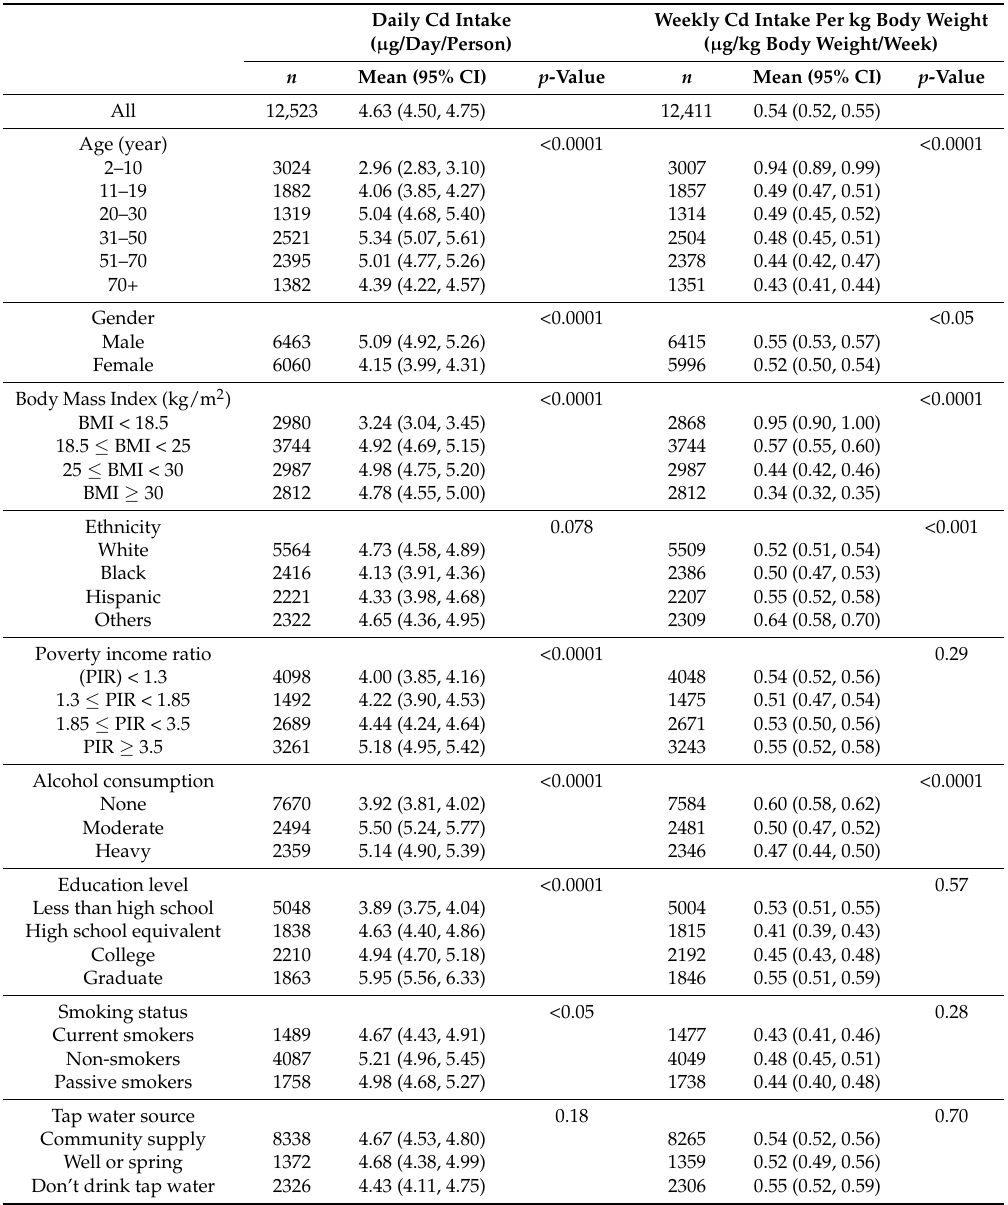
Table 1. Daily Cd intake and weekly Cd intake per weight among the US population aged ≥ 2 years by sociodemographic and lifestyle characteristics in National Health and Nutrition Examination Survey (NHANES) 2007–2012 ( n =